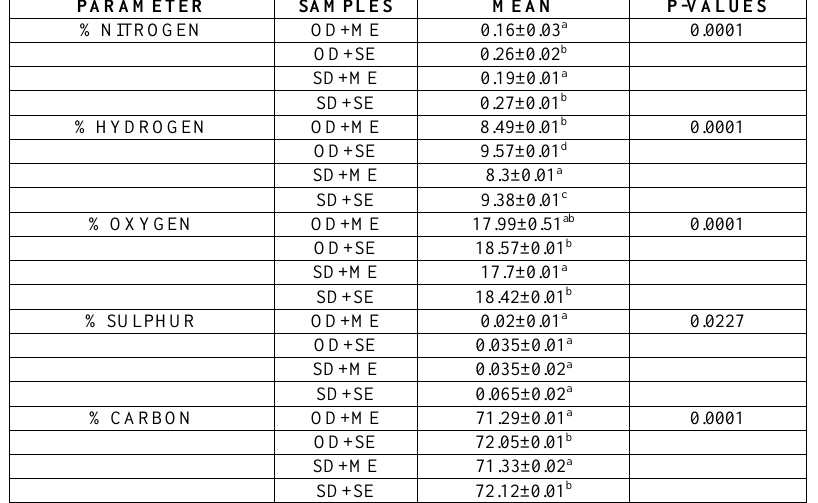
Table 2: Elemental analysis of seed